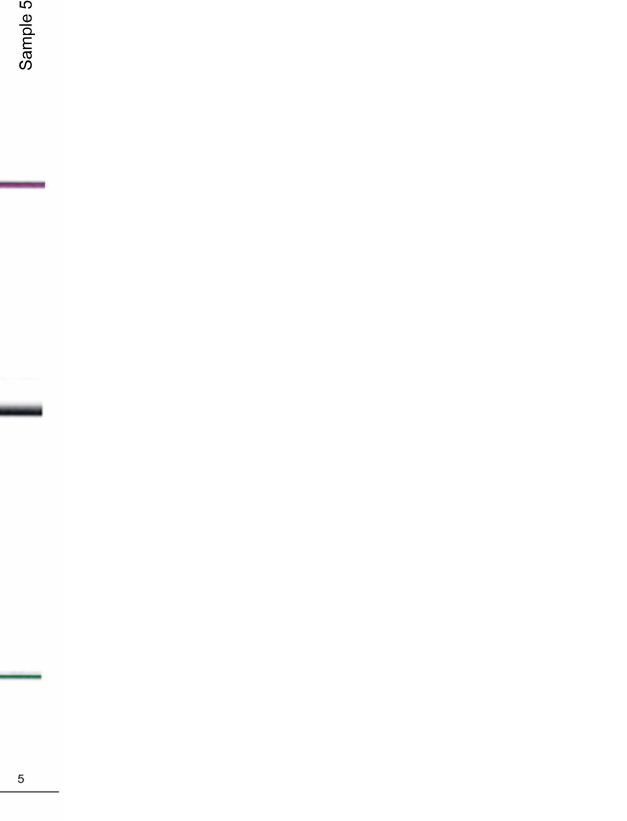
Figure 3. Qualitative RT-PCR analysis of canonical CLCN5 -204 isoform mRNA. Image generated by Agilent 2100 bioanalyzer of amplified exon 2 in CLCN5 − / − (lines 1 and 2) and WT clones (lines 3, 4, and